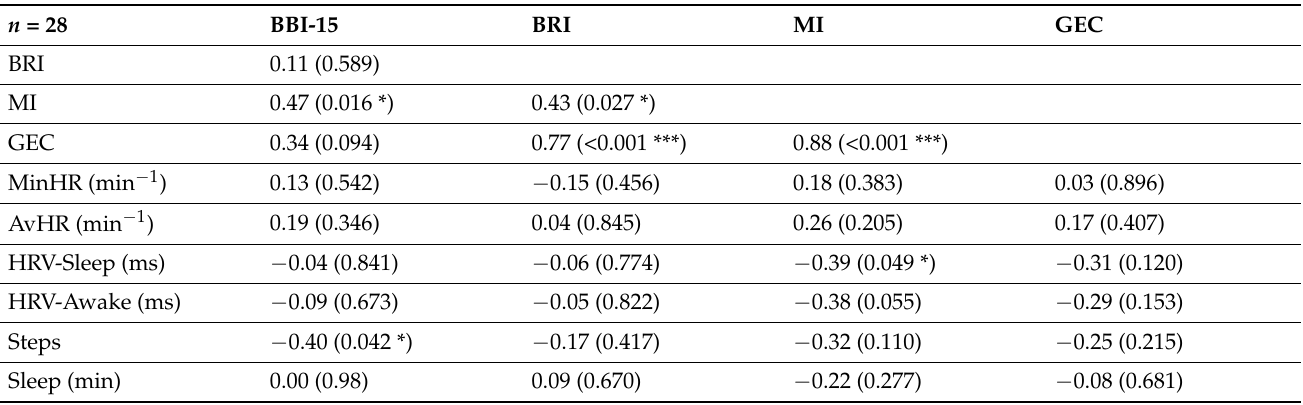
Table 4. Spearman’s partial rank correlation coefficients and statistical significances for BBI-15 score, BRIEF-A indices, and Firstbeat ® results with gender and BDI score controlled for ( p < 0.05 (*), and p < 0.001